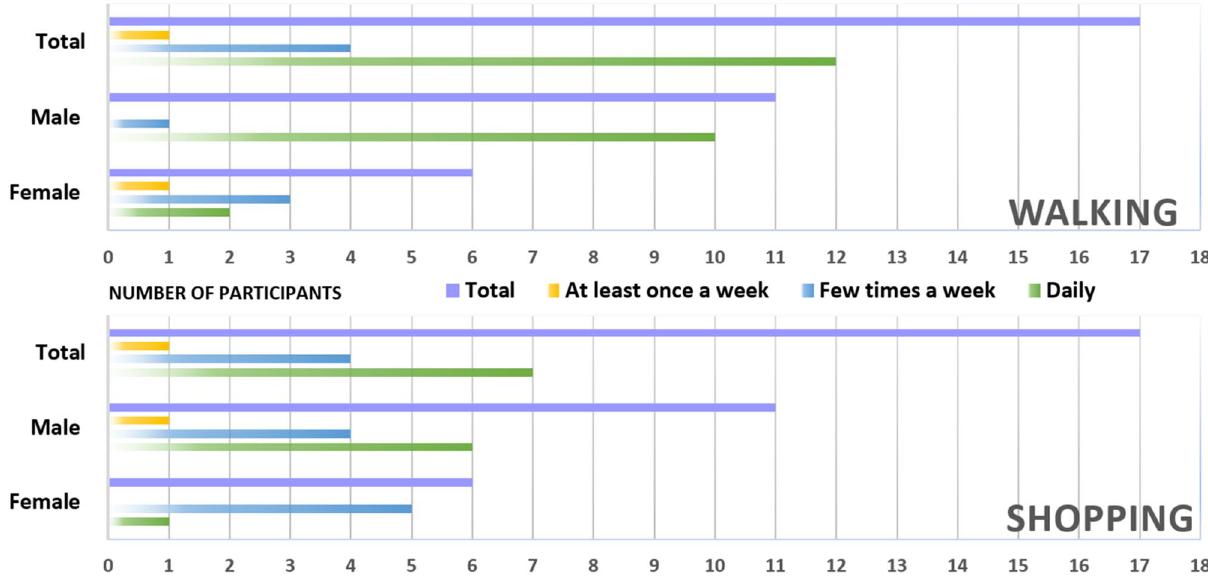
Figure 2. Walking and Shopping frequency of participants.